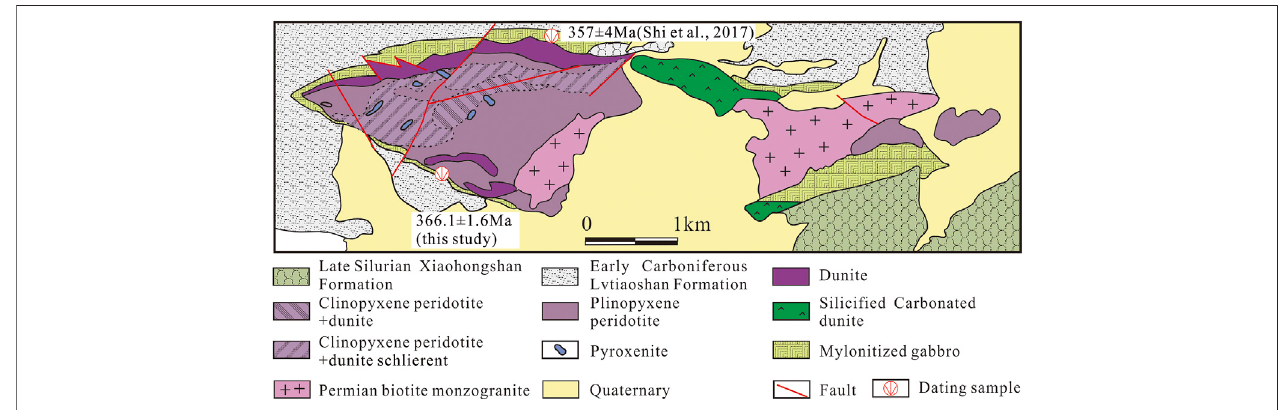
FIGURE 2 | Simpli fi ed geological map of the Hongshishan complex (modi fi ed after Wei, 1978).